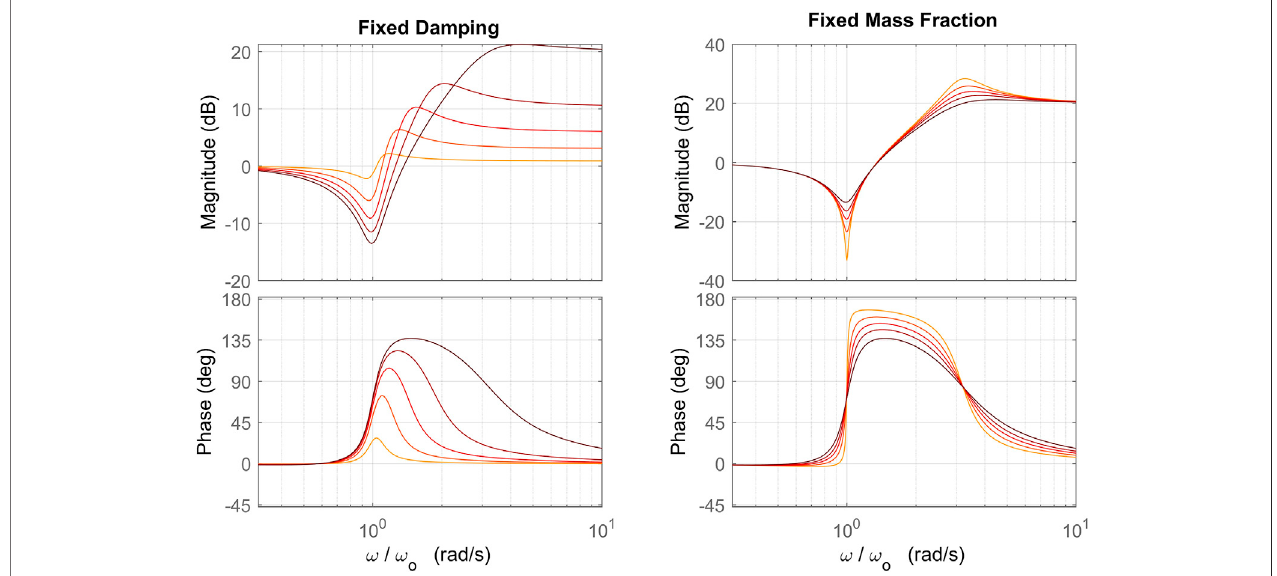
FIGURE3 | Frequency responseofthe perturbation with frequency normalized to thefrequency parameter ω o .The plot on the leftshows variation ofthe response withinertiafraction α ∈ {0.1,0.3,0.5,0.7,0.9}(darkercolorindicateshigher α )and fi xeddamping ξ (cid:2) 0.1,whiletheplotontherightshowsvariationoftheperturbationwith damping ξ ∈ {0.01,0.03,0.05,0.07,0.1} (darker color indicates higher ξ ) and fi xed inertia fraction α (cid:2) 0.9.